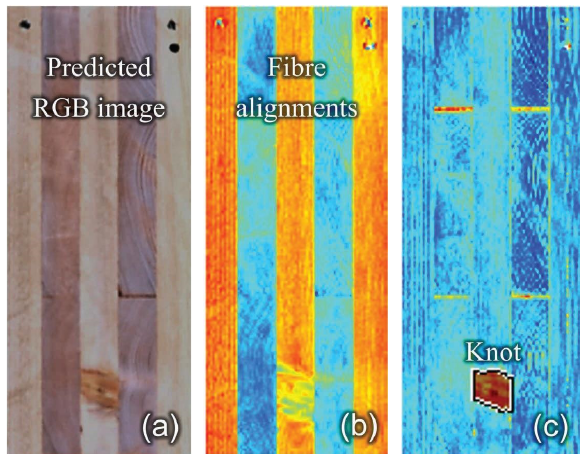
Figure 2: (a) Predicted RGB image; (b) the frst principal com- ponent analysis (PCA) contour plot component distinguished longitudinal 0 ° and transverse 90 ° layers in cross-laminated timber (CLT); and (c) the second PCA contour plot component de- termined a knot.